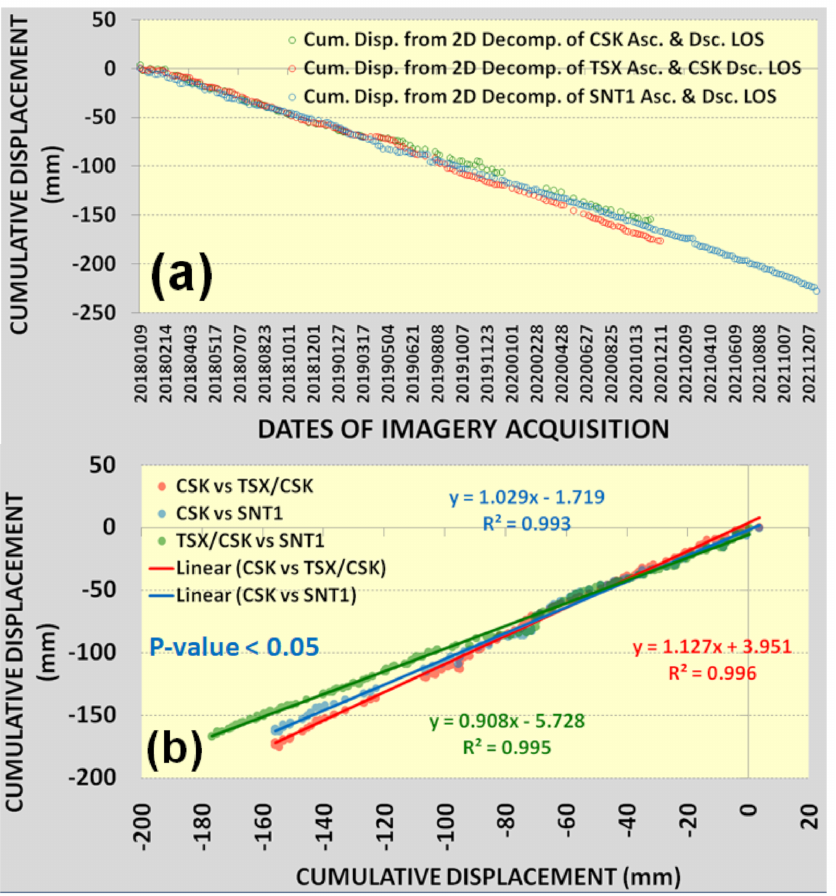
Figure 12. ( a ) Cumulative vertical displacements for the detected maximum subsiding location (intersection of profile 1 & profile 2); ( b ) regression for cumulative vertical